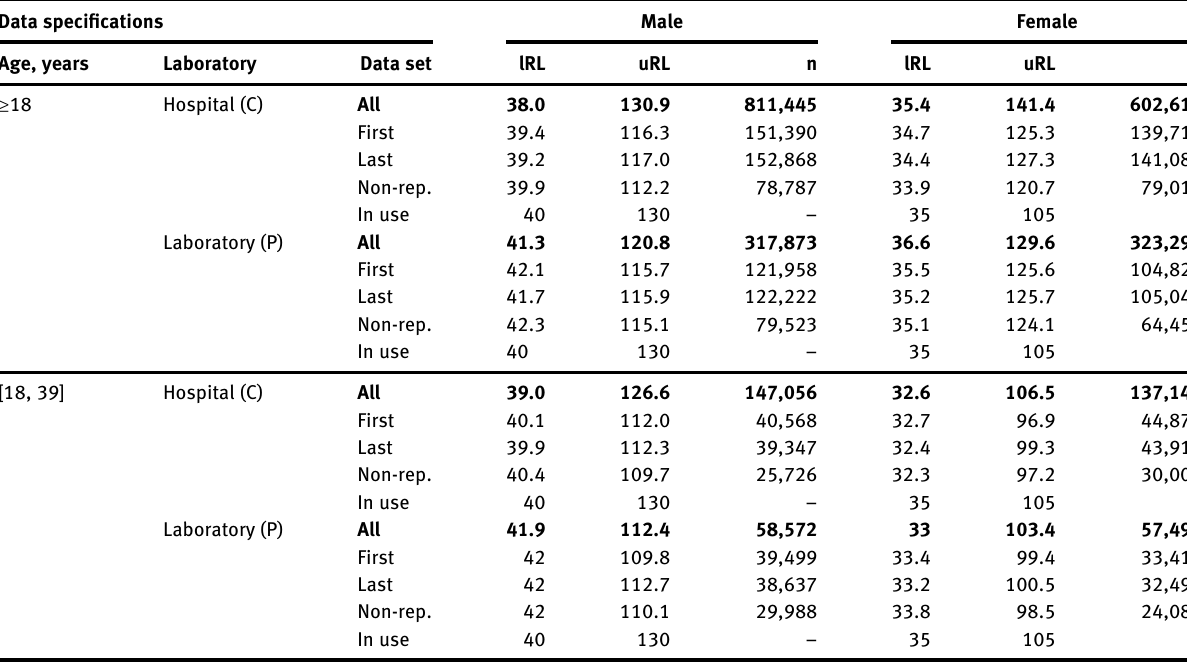
Estimated RLs through all values (bold rows) indicate most deviation from others. Used RLs in each laboratory are given, too. Non-rep.,